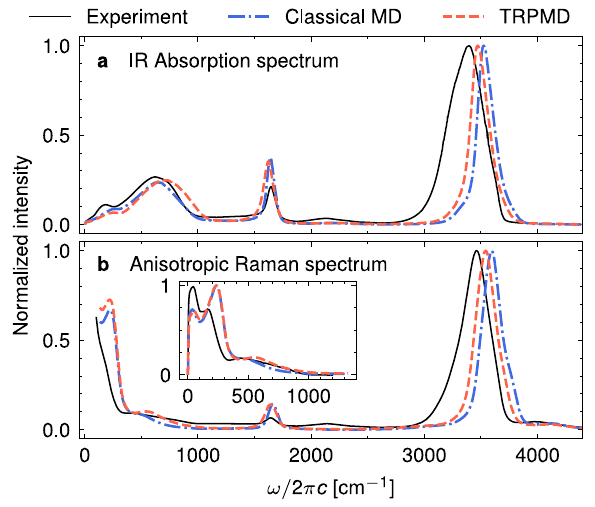
Fig.1|Steady-statespectraofwater. IRabsorption( a )andanisotropicRaman( b ) spectra of liquid water at 300K simulated with the classical MD and TRPMD, comparedwiththeexperimentsofrefs.16,27,91.Theinsetinpanel b comparesthe low-frequency part of the simulated and experimental anisotropic Raman